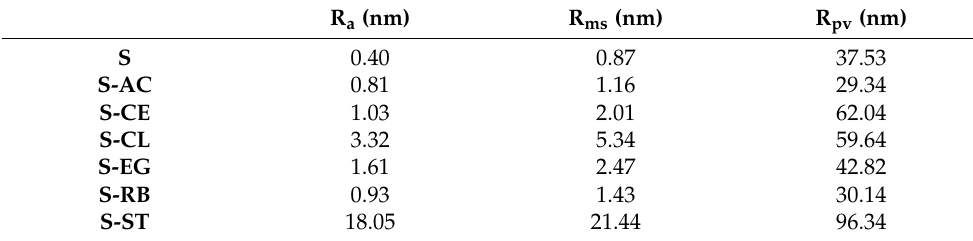
Table 2. Roughness parameters of the composite